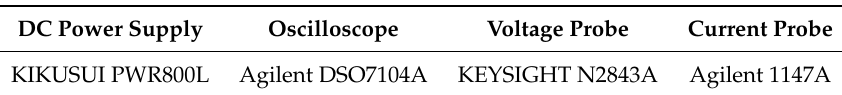
Table 2. Experimental